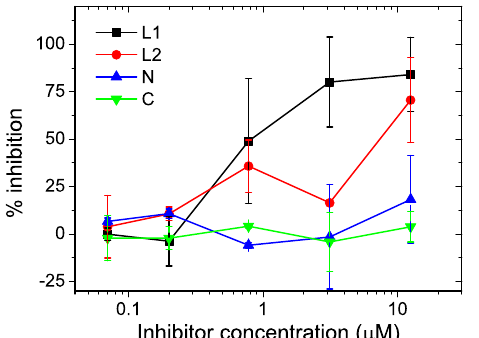
Figure 10. In vitro inhibition of SARS-CoV-2 infection of Vero 76 cells by CoVS-HR1 proteins. Vero 76 cells were infected by primary viruses (B1 D614G genotype) in the presence of CoVS-HR1 proteins at varying concentrations. The percentage of inhibition was calculated according to the reduction in percentage of infected cells treated with inhibitor compared to the percentage of infected untreated control cells. The percentage of infected cells in each well was recorded by measuring the number of infected cells (labeled by antinucleocapside antibody) and the total number of cells (by Sytox Green staining) using an imaging cytometer. The data and error bars correspond to the mean and standard deviation from two independent